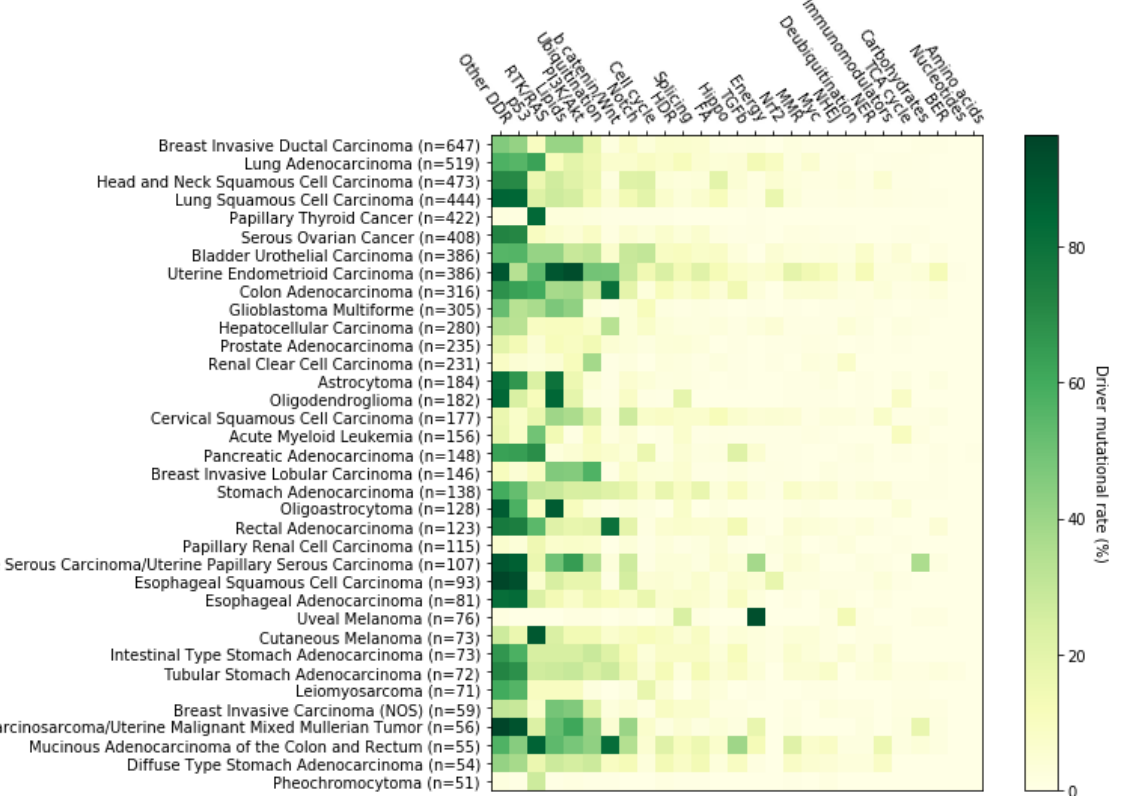
Figure 3. Alteration rate of 27 signaling pathways across 36 cancer types/subtypes. For this analysis, 10,066 tumor samples of primary origin and with available mutational profiles were examined for the presence of somatic driver mutations in our 204 genes of interest. Calculations were performed by taking into account all the available mutationally profiled primary tumor samples of the cBioPortal selected studies (10,066 samples) instead of the driver event-harboring mutationally profiled primary tumor samples (7915 samples). If for a selected cancer type there were x mutationally profiled primary tumor samples available in the cBioPortal selected studies, then, y samples would bear at least one driver event in at least one of the 204 genes of interest and z samples would harbor driver events in genes participating in a selected signaling pathway. The corresponding driver mutational rate for this cancer type-signaling pathway pair is calculated as (z/x) × 100. Here, only cancer types/subtypes that entail more than 50 analyzed samples are shown. From left to right, signaling pathways are displayed in descending order of total mutational frequency. n: number of samples examined.